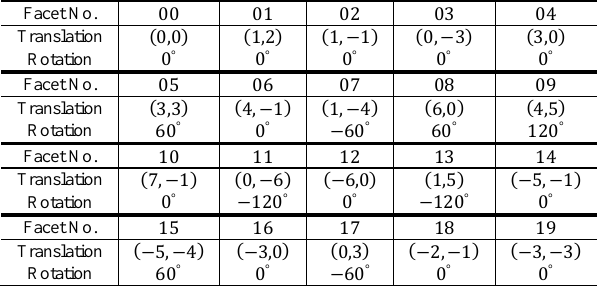
Table 4. Subdivision layer n =2, 00 area was taken as the center for the icosahedron unfolding, the translation parameters ( ) and rotation parameters from the local coordinate system on the triangle facet to the global coordinate system on the icosahedron unfolding area.